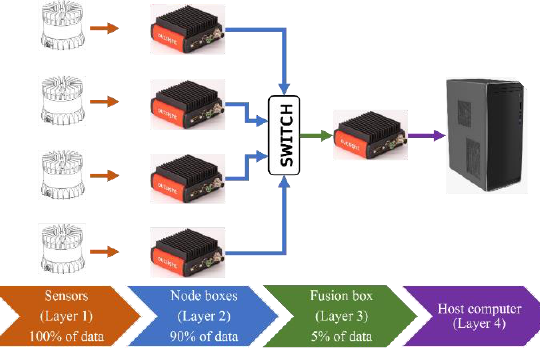
Figure 4 . LiDAR system connection and data